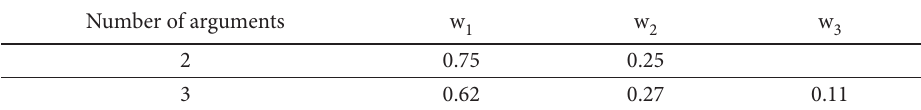
Table 4. Weighting vectors for various numbers of